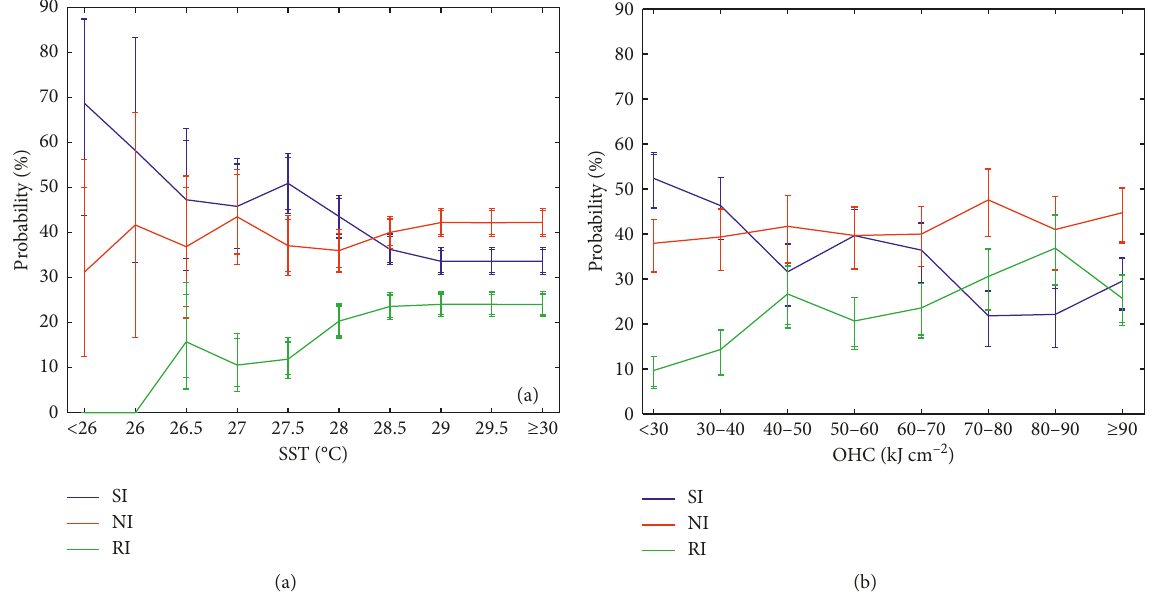
Figure 15: : The same as in Figure 9, but for ocean heat condition: (a) SST ( ° C) and (b) OHC (kJ cm − 2